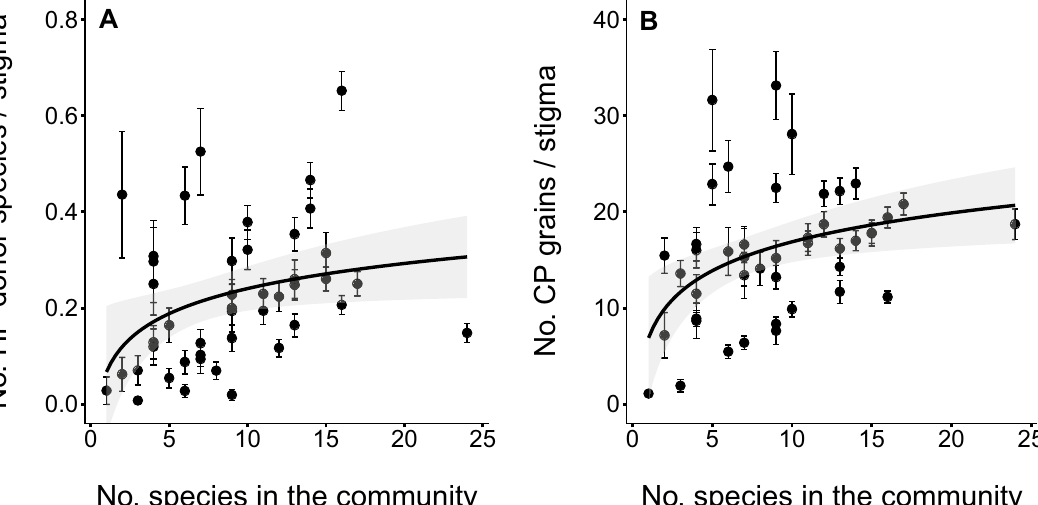
Figure 4. Mean ± SE values for the number of ( A ) heterospecific pollen (HP) donor species per stigma and ( B ) conspecific pollen (CP) grains per stigma as a function of the total number of plant species in bloom present in the community. Model predicted values (solid line) and 95% confidence intervals (shaded area) are shown. Each point represents the mean across all species within each combination of mountain, altitude and sampling